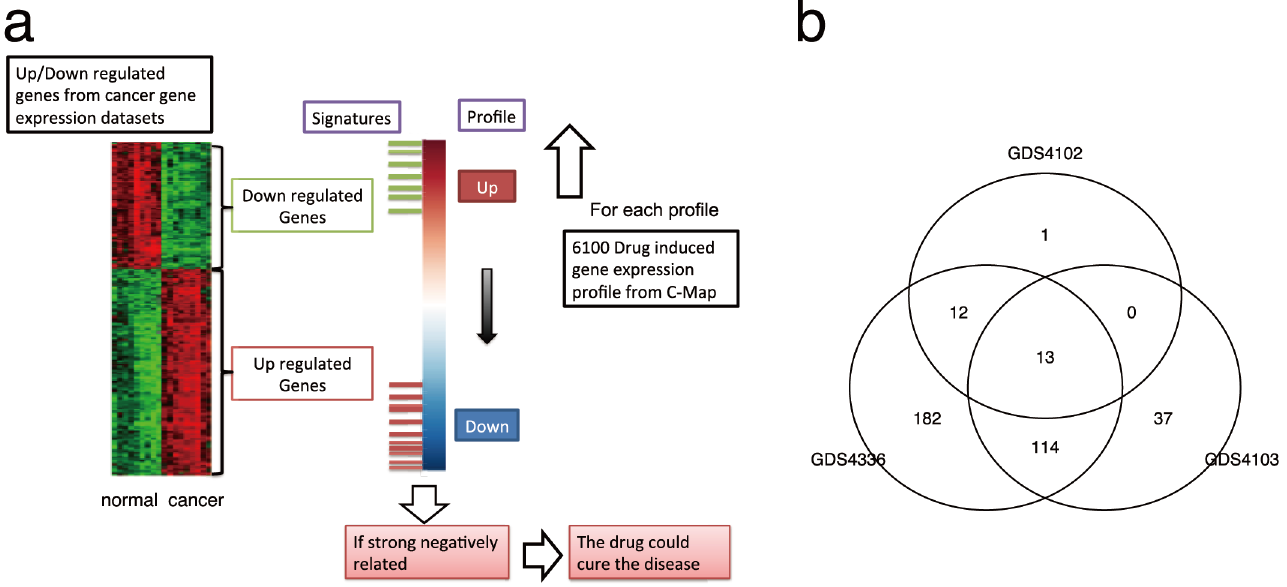
Fig 1. Identification of potentially useful drugs (PUDs) for treating pancreatic cancer using gene expression-based correlation analyses. A. Workflow. B. Venn Diagram for the PUDs identified for each of the three pancreatic cancer datasets.